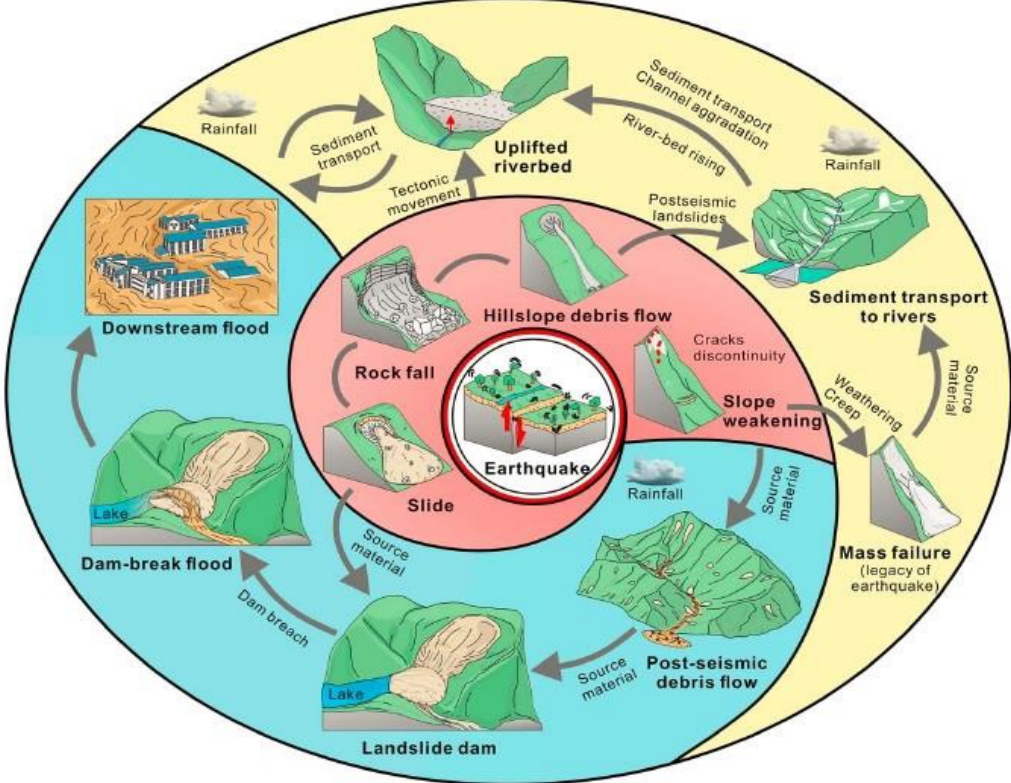
Figure 5. Geologic cascading hazards triggered by earthquake.